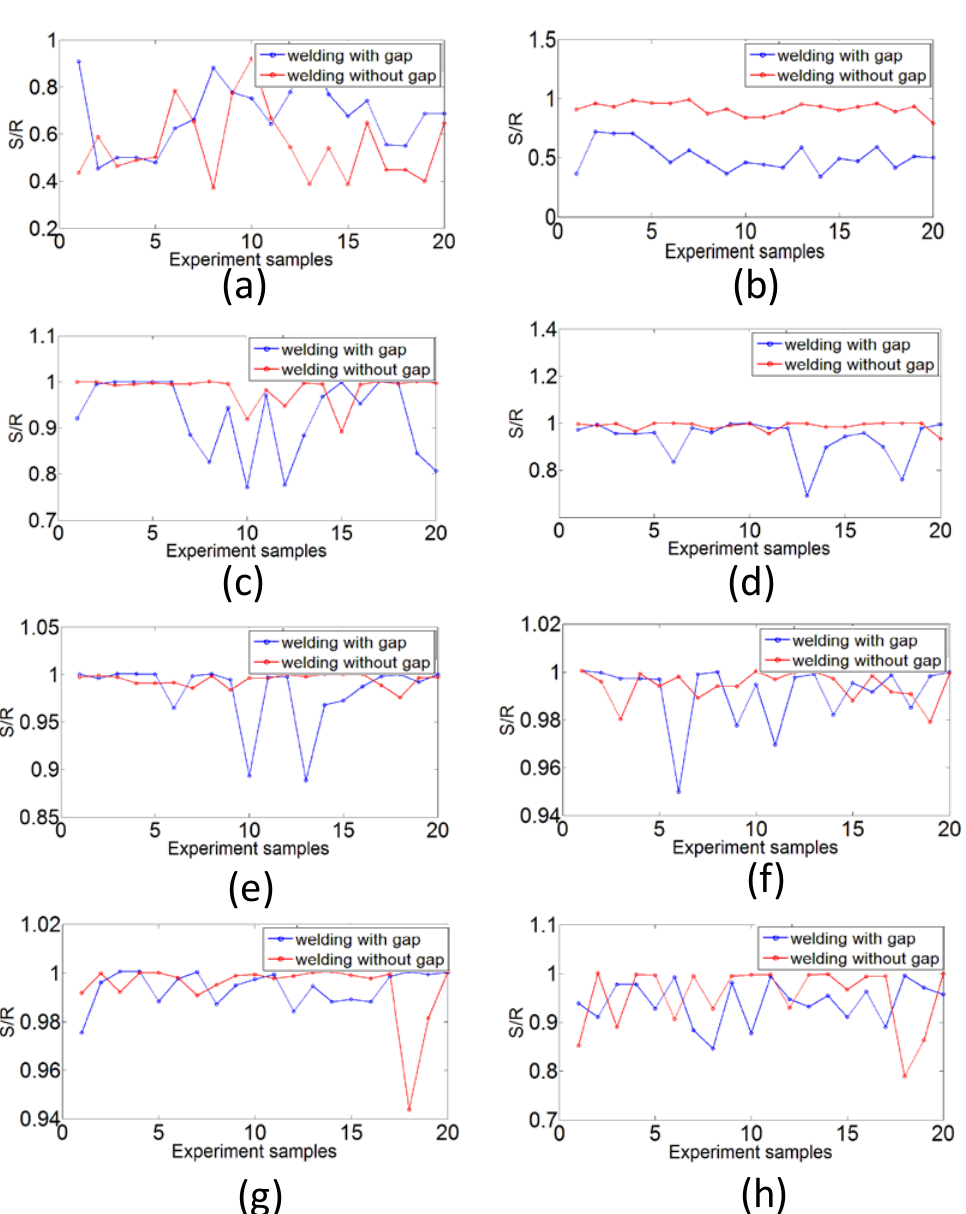
Figure 13. STD-to-RMS ratio for a selected section with high- and low-joint-bonding strengths: ( a ) first section; ( b ) second section; ( c ) third section; ( d ) fourth section; ( e ) fifth section; ( f ) sixth section; ( g ) seventh section; ( h ) eighth section.